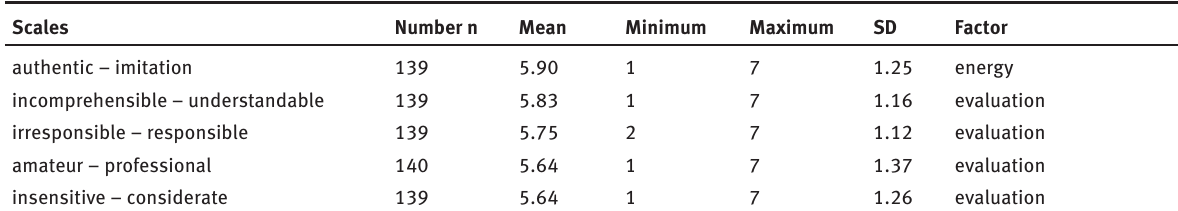
Table 5: Standard scales with the highest rating Scales